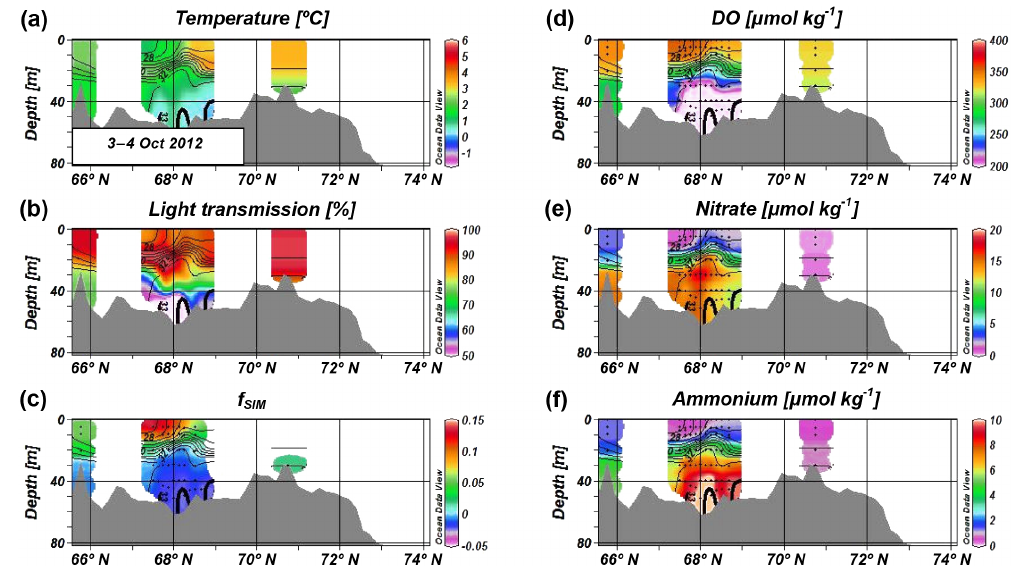
Figure 6. Vertical sections of (a) temperature ( ◦ C), (b) light transmission (%), (c) fraction of sea ice meltwater, (d) dissolved oxygen (µmolkg − 1 ) , (e) nitrate (µmolkg − 1 ) , and (f) ammonium (µmolkg − 1 ) along the 168 ◦ 45 (cid:48) W meridian near the US–Russia border obtained during the 3–4 October 2012 R/V Mirai cruise. The water sampling level at each station is indicated by a black dot. Salinity contours are superimposed on each section with a 0.5 contour interval. The thick contour in each section indicates a salinity of 33.